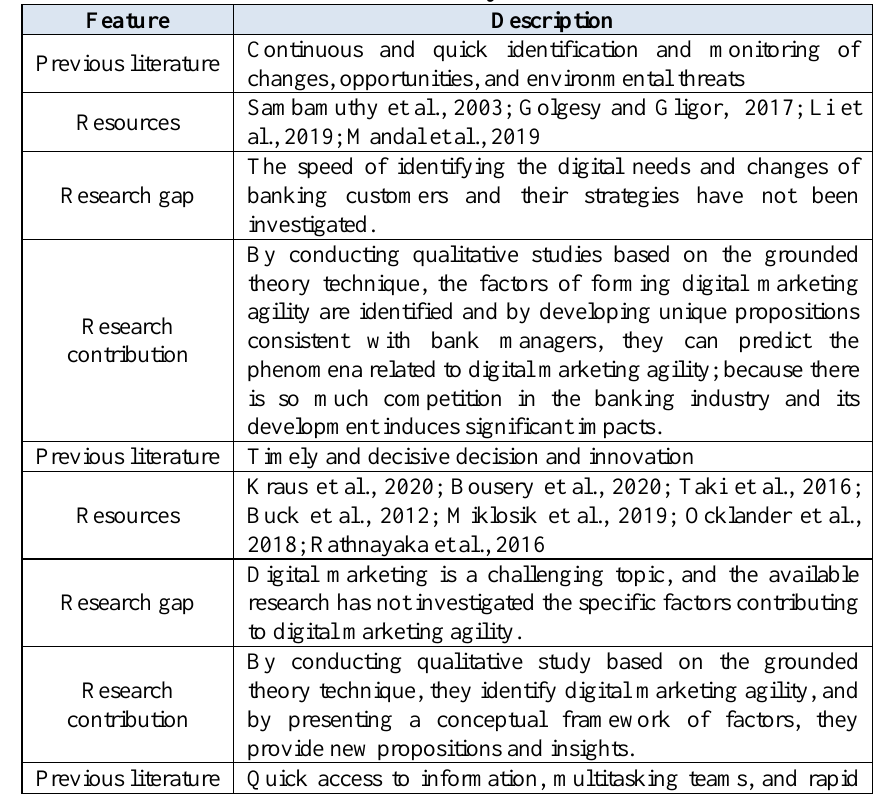
Table 1. A review of existing literature, research gap and contribution of this